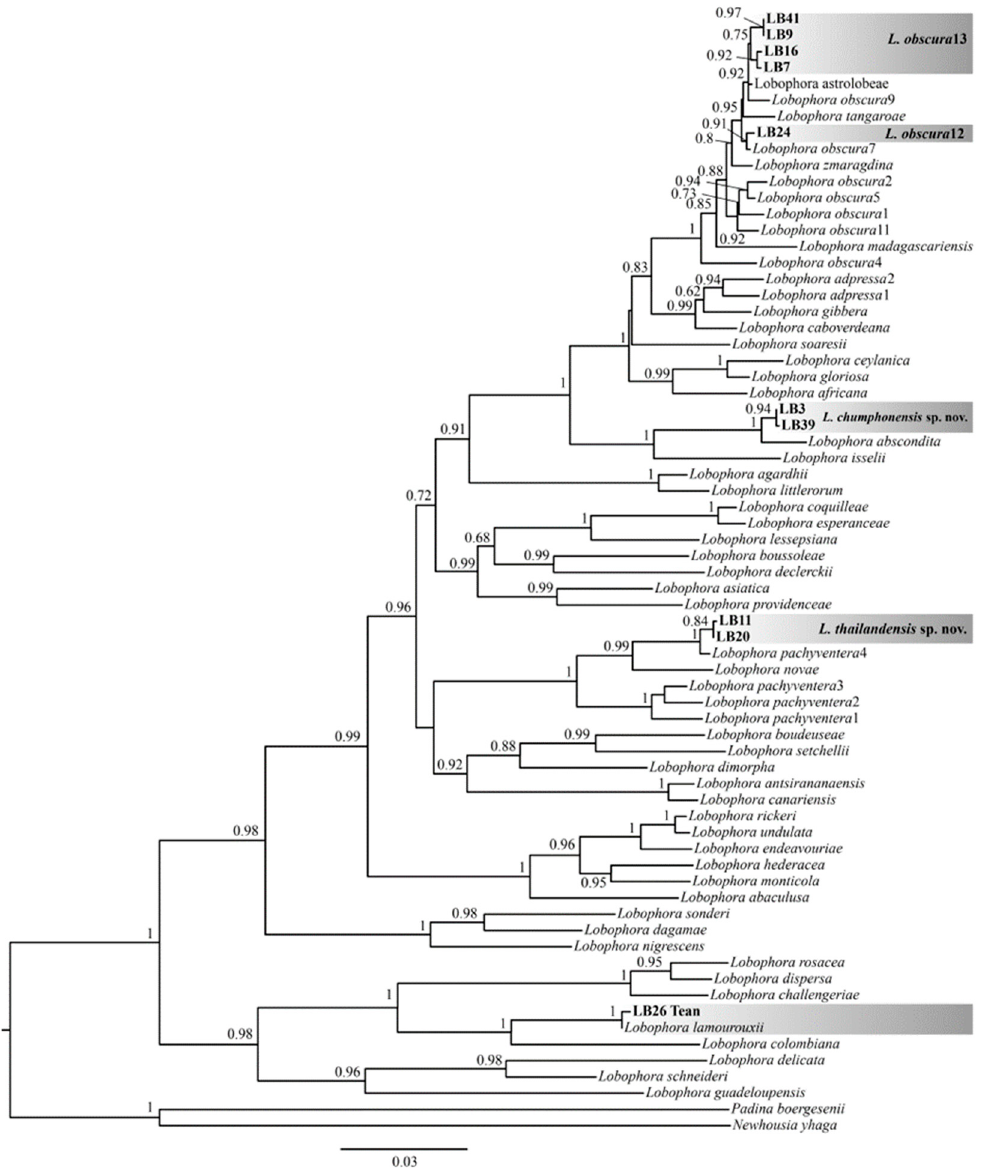
Figure 1. Species-level maximum likelihood (PhyML) phylogenetic tree of the brown algal genus Lobophora (Dictyotlaes, Phaeophyceae) constructed using one mitochondrial ( cox 3) and chloroplast ( psb A and rbc L) sequences (3102 bp). Branch support values (aLRT) are displayed in the nodes. 2.1.1. Lobophora chumphonensis sp. nov. A. Klomjit and C. Vieira (Figure 2g,h, Table 1.)